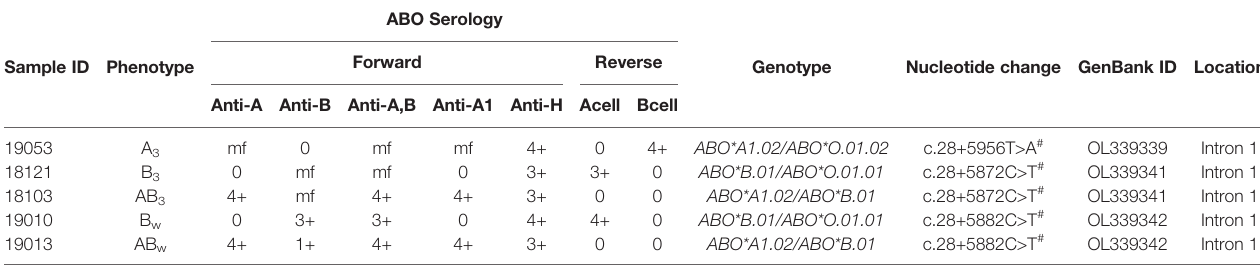
TABLE 5 | The results of the fi ve ABO subtypes with no variations in the coding region by NGS method.